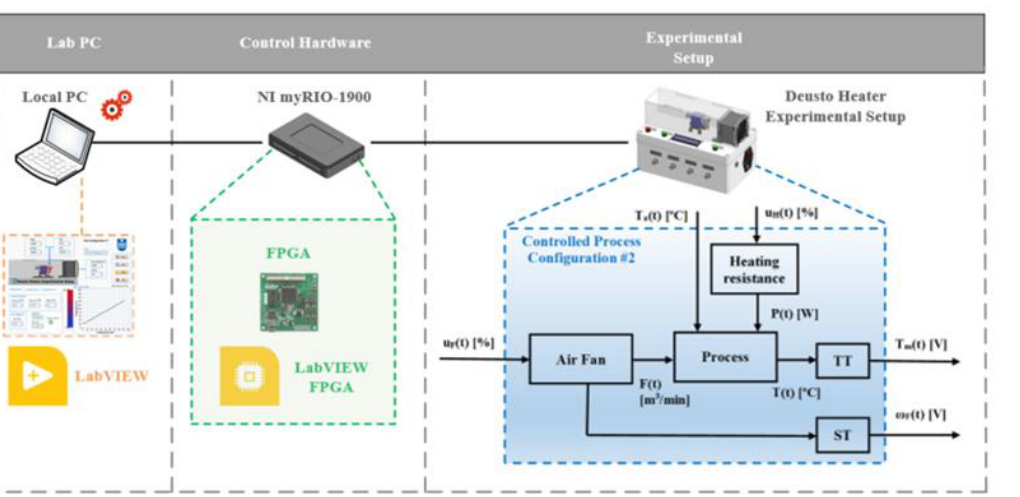
Figure 22. Scheme of FPGA-based closed-loop implementation of temperature control with Con- trolled Process Configuration #2.